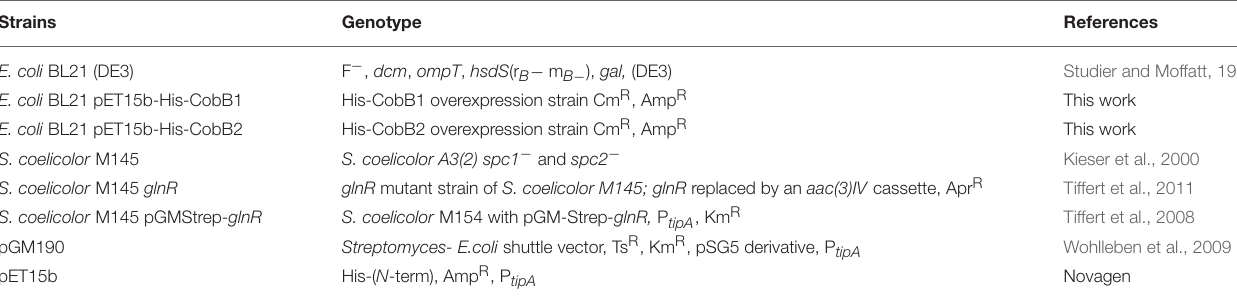
TABLE 1 | Strains and plasmids used in this study.